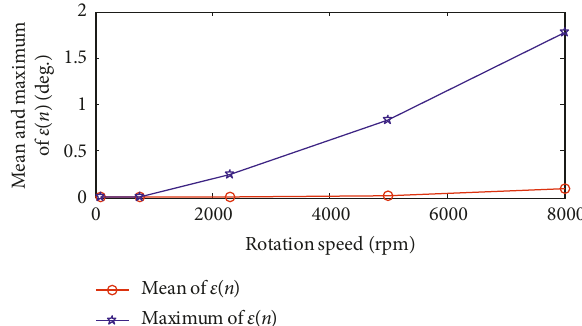
Figure 8: Estimation error of θ